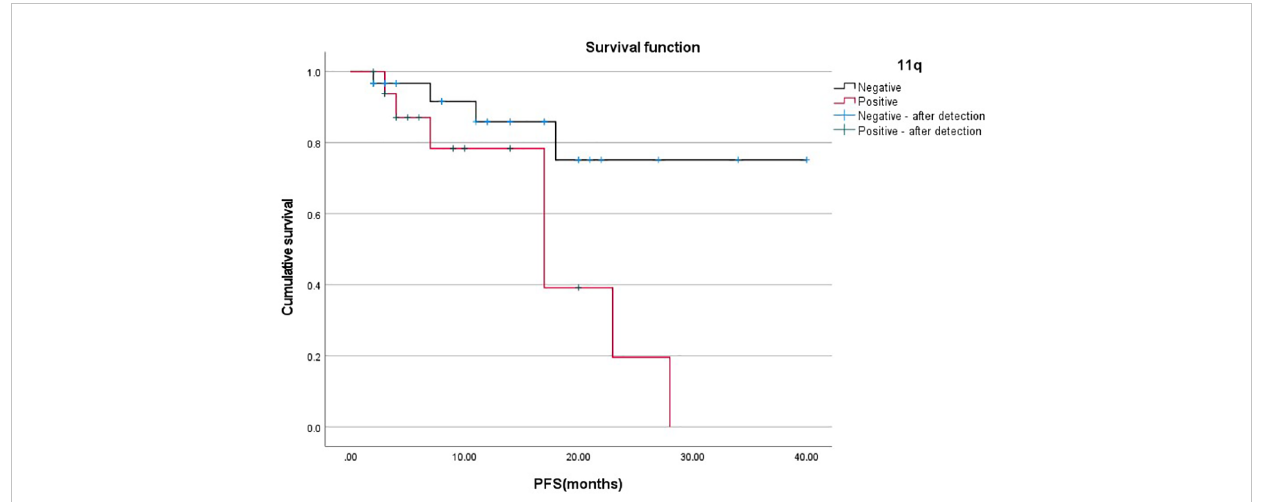
FIGURE 1 Relationship between 11q gene deletion and